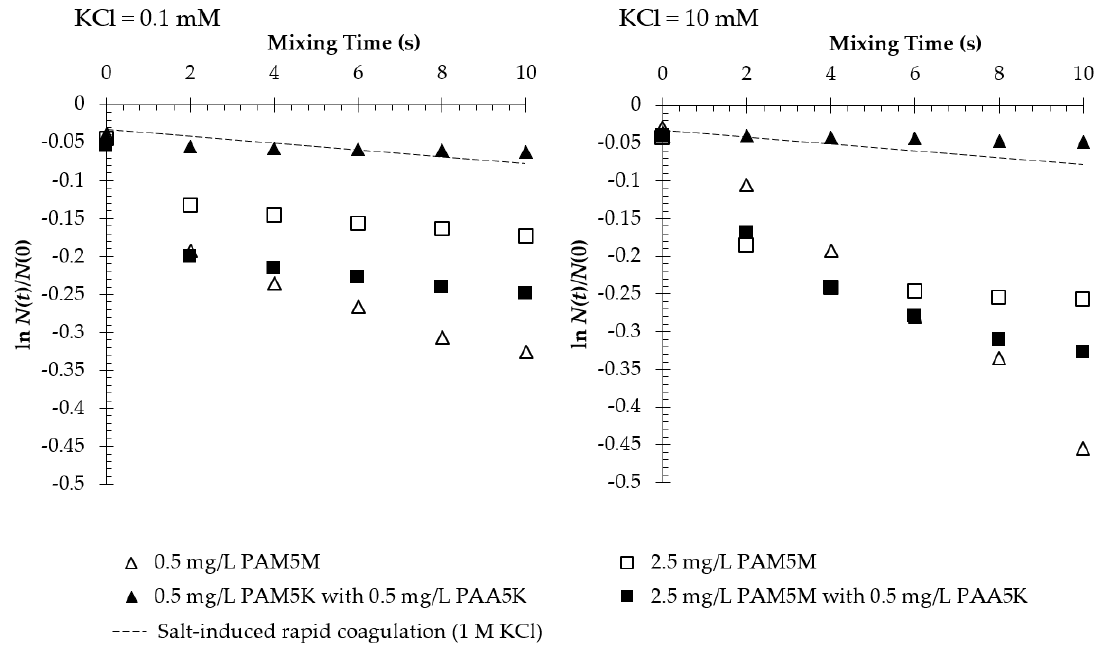
Figure 7. Temporal variation of the rate of polycation-induced flocculation in 0.1 mM and 10 mM KCl with/without PAA5K.